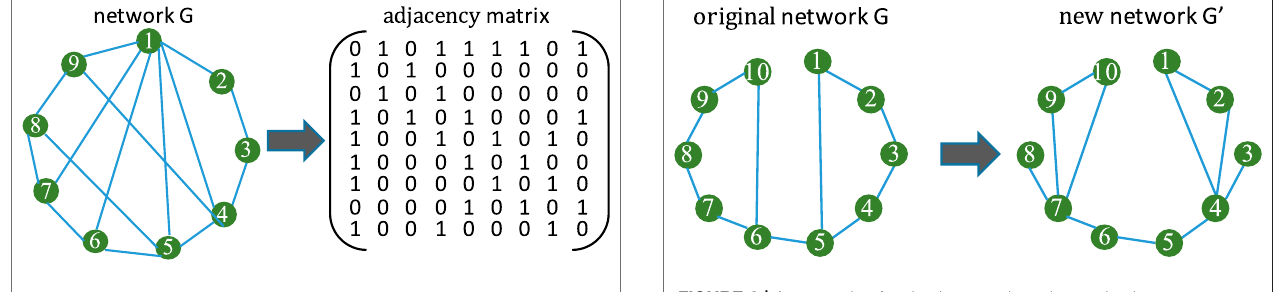
FIGURE 1 | An example of a simple network together with its corresponding adjacency matrix.